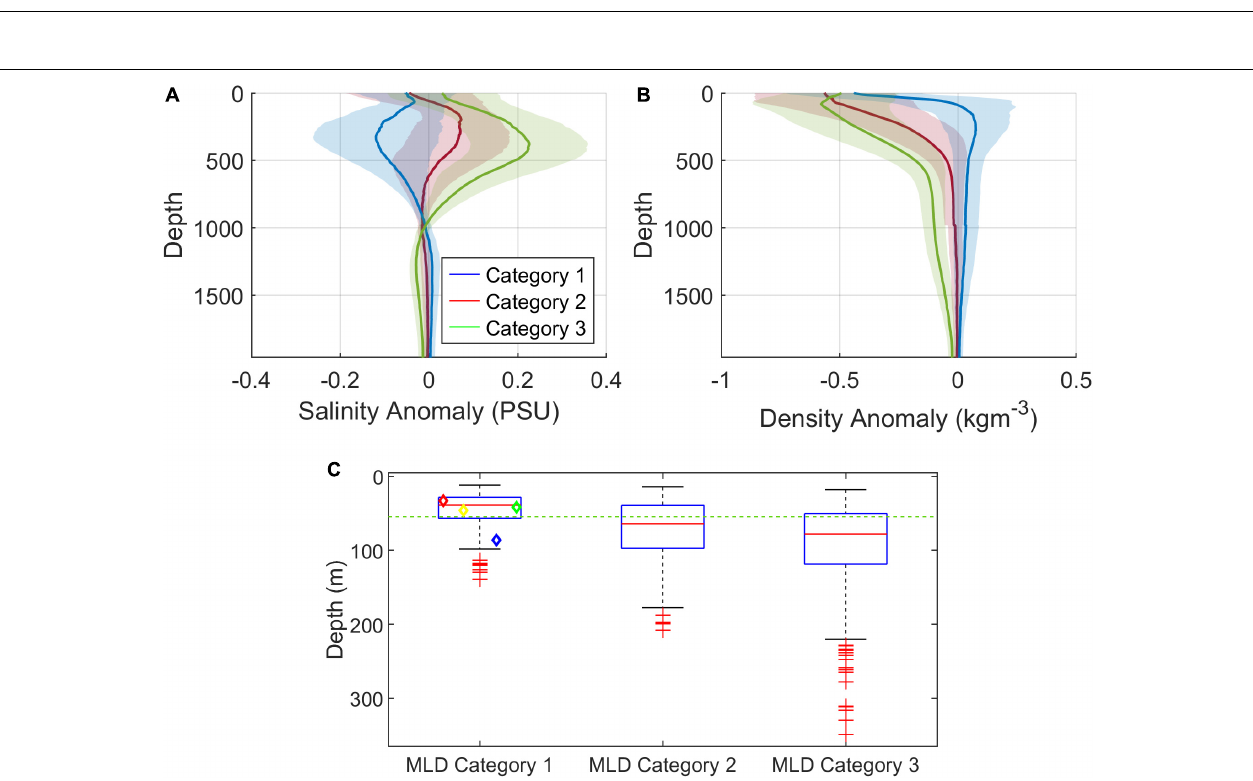
FIGURE 7 | Standard deviation (shading) and mean (thick lines) show the spread of salinity (A) and density (B) anomalies during MHWs per category. Panel (C) shows the median, standard deviation and 25th–75th percentiles of the MLD during MHWs of category 1, 2, and 3. Category 1 seasonal MLD is indicated by colored diamonds (summer DJF, autumn MAM, winter JJA and spring SON shown with red, yellow, blue and green diamonds, respectively). The mean climatological MLD in the region (57 m) is shown for reference with a dashed green line. Outliers are indicated with red crosses.